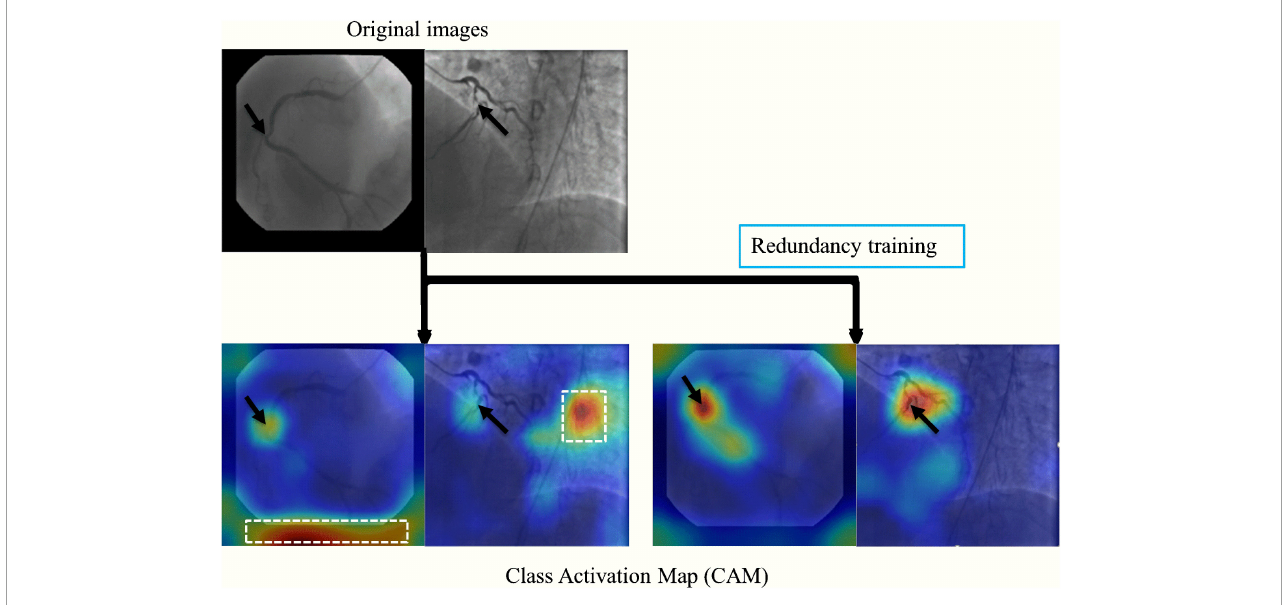
FIGURE4 A representative image of the effect of the redundancy training demonstrated in a heatmap style. In the original training, the model had mid-to-high level attention on background regions. The redundancy training reduced the overfitting caused by background structures and improved the performance of stenosis